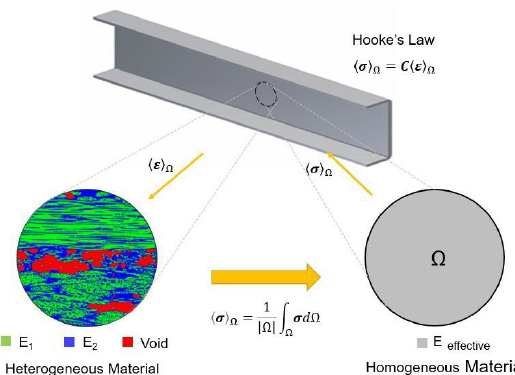
Figure 14. Homogenization procedure of a heterogeneous material: Application of a unitary deformation at the macro scale; computation of a stress field in the micro scale; computation of the average stress; and calculation of the effective tensor in the macro scale using the Hooke’s